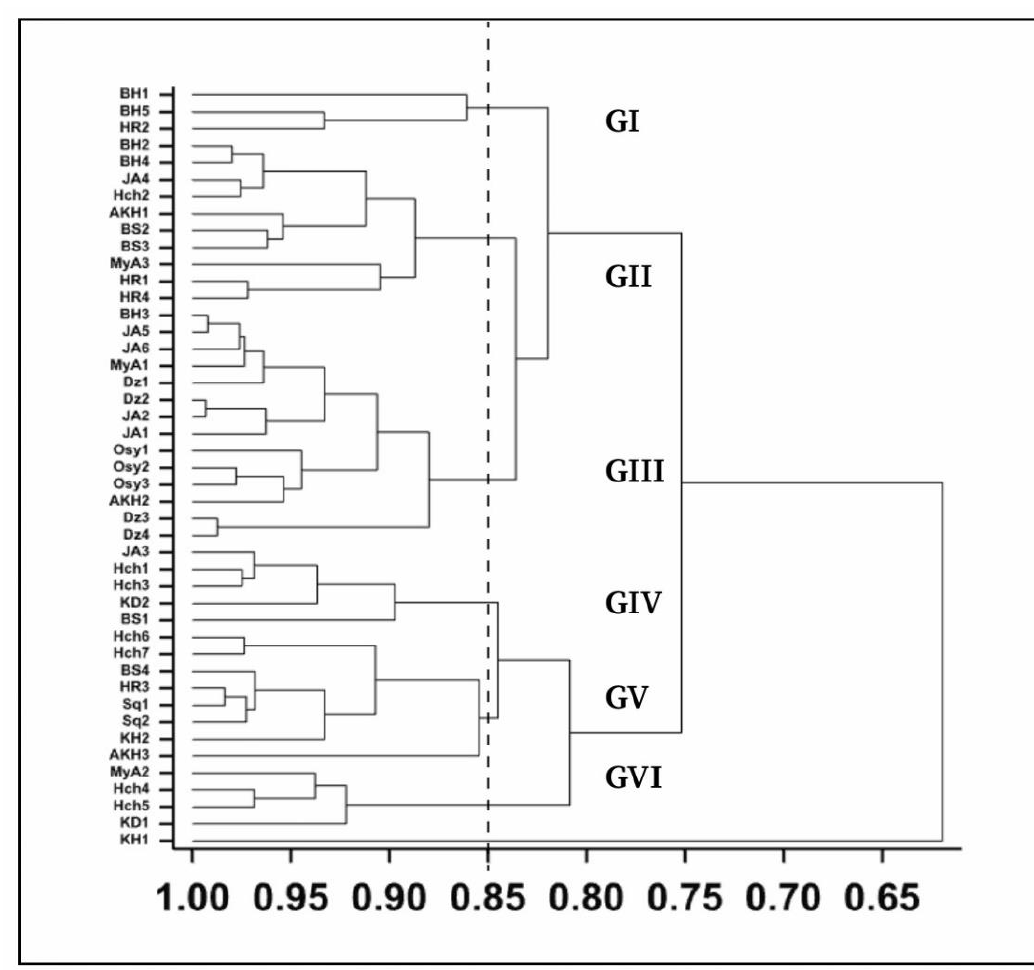
Figure 4. Hierarchical clustering Dendrogram showing the relationships among the forty-five samples belong to the surveyed regions.